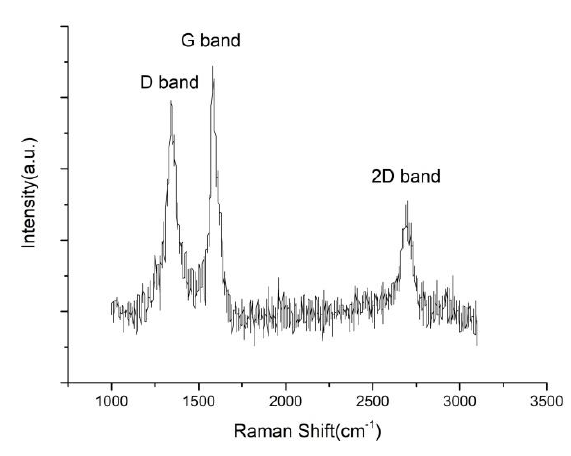
Figure 2. The Raman spectrum of rGO in the Ni–P–rGO coatings.